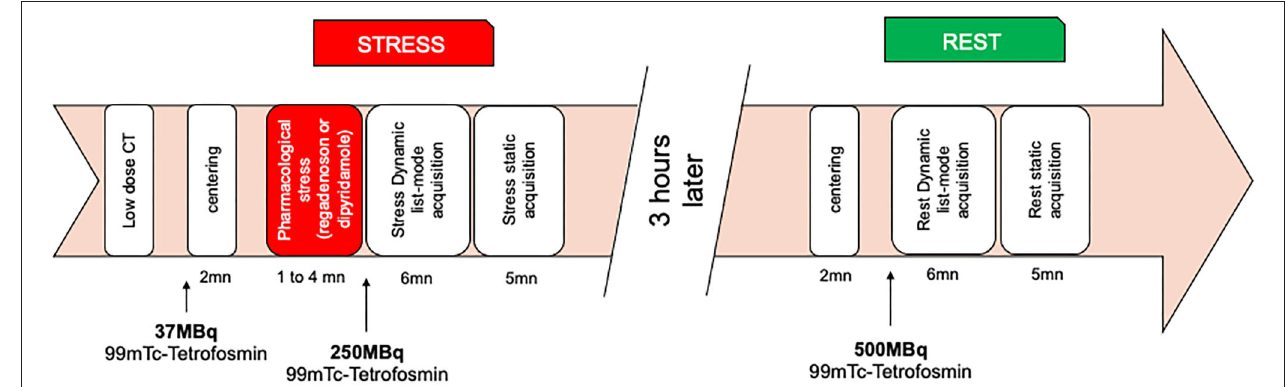
FIGURE 2 | Dynamic cardiac myocardial perfusion imaging